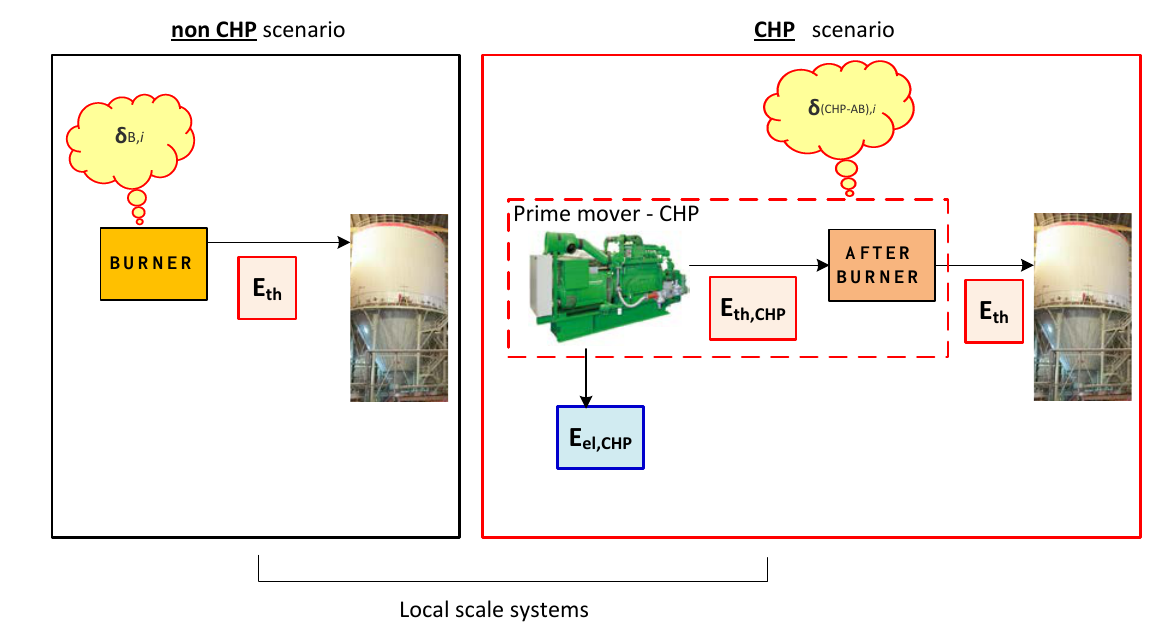
Figure 7. Emission assessment scenarios.